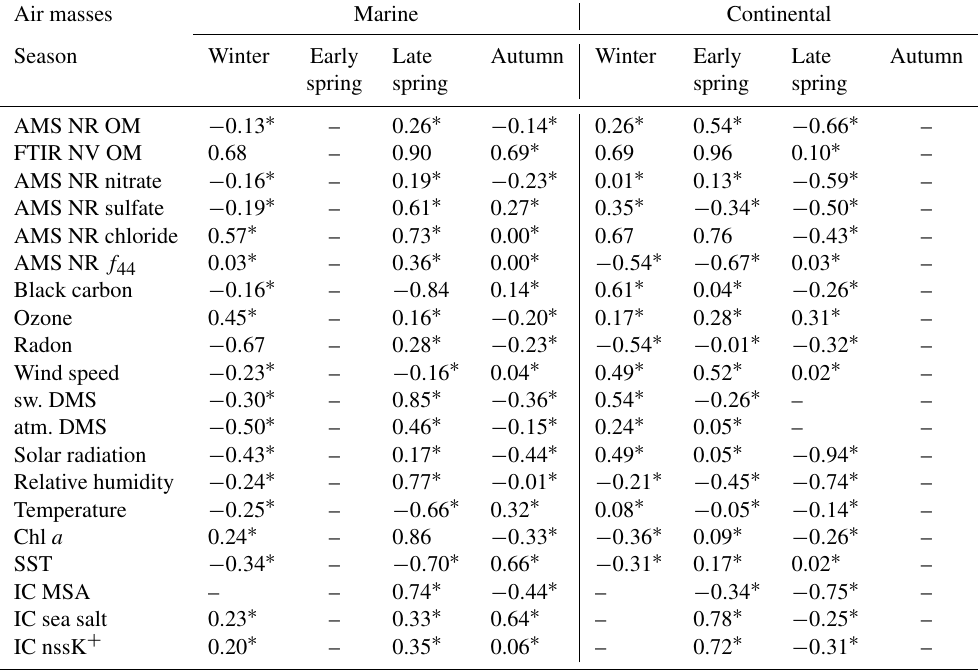
Table 5. Pearson correlation ( R ) coefficient values between FTIR NV amine groups (ADL and BDL) in particles with diameters < 1µm and various tracers for marine periods (columns on the left) and continental periods (columns on the right). The strength of each correlation is given by the magnitude of R : no correlation ( | R | < 0 . 25), weak correlation (0 . 25 ≤ | R | < 0 . 50), moderate correlation (0 . 50 ≤ | R | < 0 . 80), and strong correlation (0 . 80 ≤ | R | ). Correlations that are not statistically significant ( p ≥ 0 . 05) are indicated by “ ∗